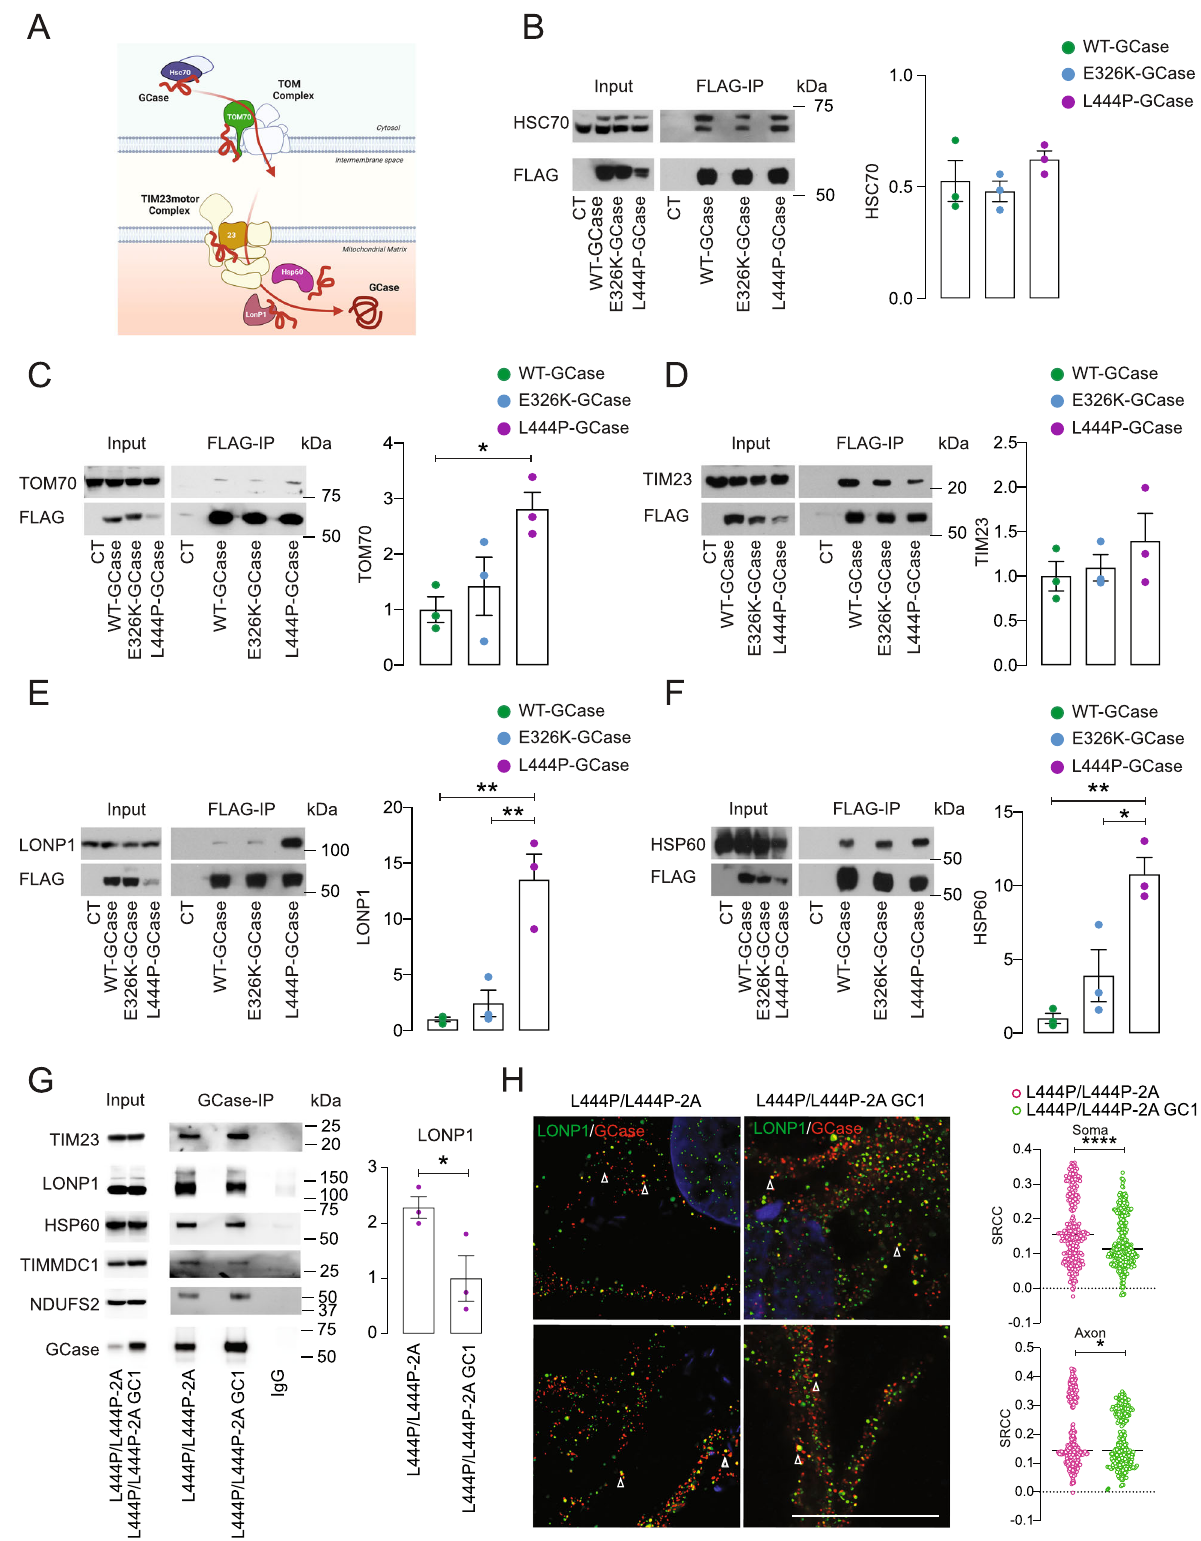
mutant recombinant L444P GBA1 organoids (Fig. 6E and Supplemen- tary Fig. 12D). In this respect, pathway analysis revealed a selective dysregulation of mitochondrial energy metabolism in DA neuron clusters from GBA1 mutant organoids compared to isogenic controls (Fig. 6E and Supplementary Fig. 12D), suggesting that severe GBA1 mutations drive selective mitochondrial disturbances in DA